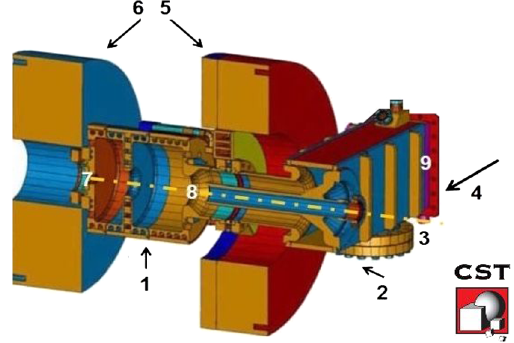
FIG. 1. Sketch of the PITZ gun in CST Microwave Studio [8]: 1-gun cavity, 2-door-knob transition, 3-cavity axis, 4-rf feeding direction, 5-main solenoid, 6-bucking solenoid, 7-cathode, 8-end of coaxial line, and 9-reference position of waveguide port for simulations. Note that, this sketch is rotated by 90 degrees compared to the computational model used for simulations.